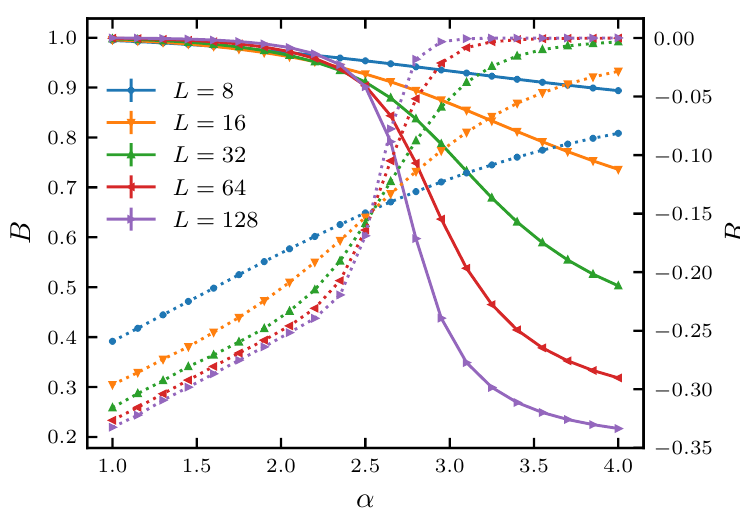
Figure 2: Binder Cumulant B (solid lines) and the log string-order parameter ratio R (dotted lines) as a function of α for different system sizes. Note the scale for B and R are on the left and right side of the frame respectively. The error bars for both quantities are smaller than the